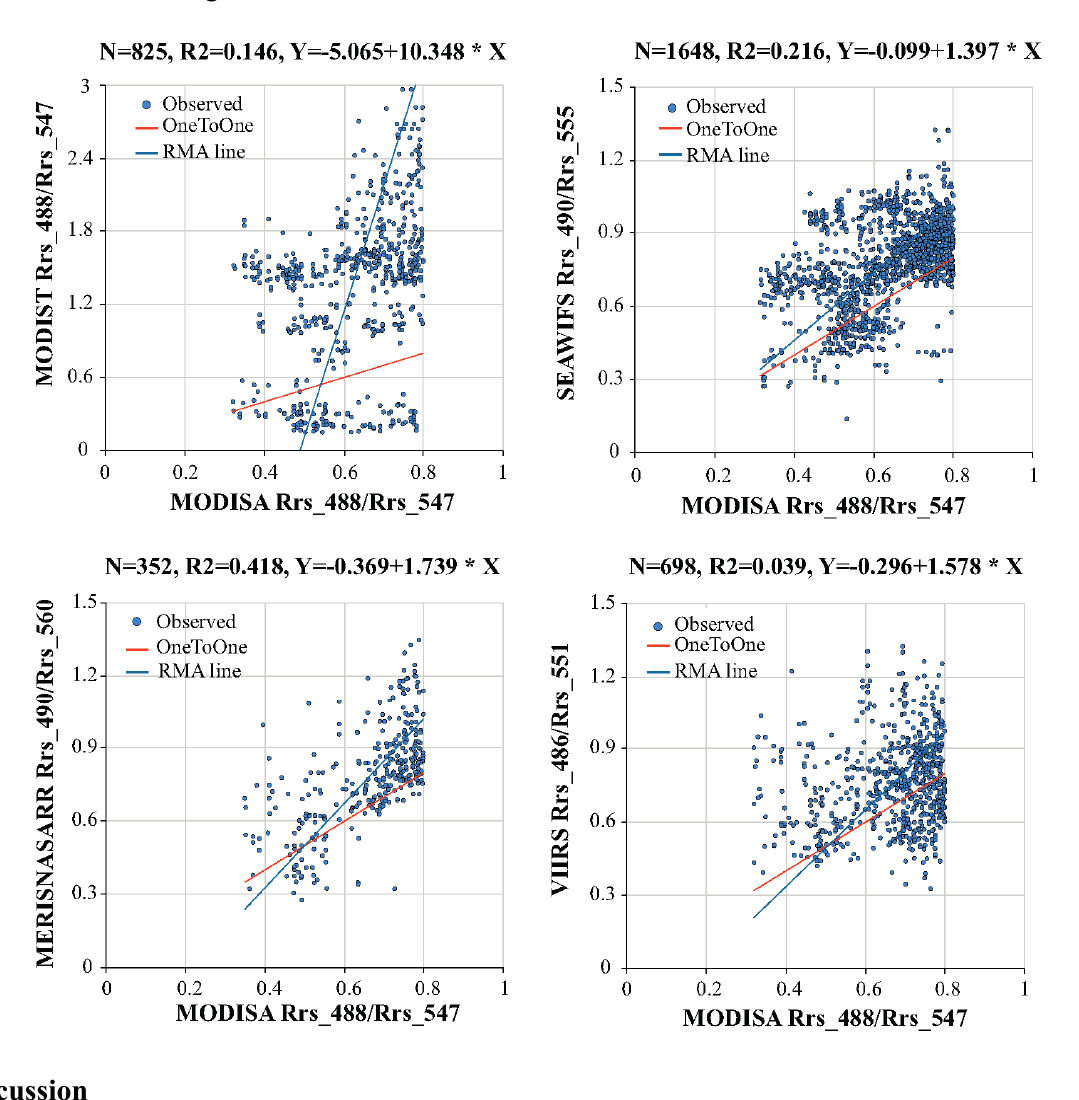
Figure 8. Inter-sensor comparison of Rrs ratios that are being used to detect high Chla by standard algorithms. The subset of MODISA pixels with Rrs _488/ Rrs _547 < 0.8 (as in Figure 7) are used, corresponding to Chla ≥ 3.3 mg m − 3 , according to the standard MODISA OC3 algorithm